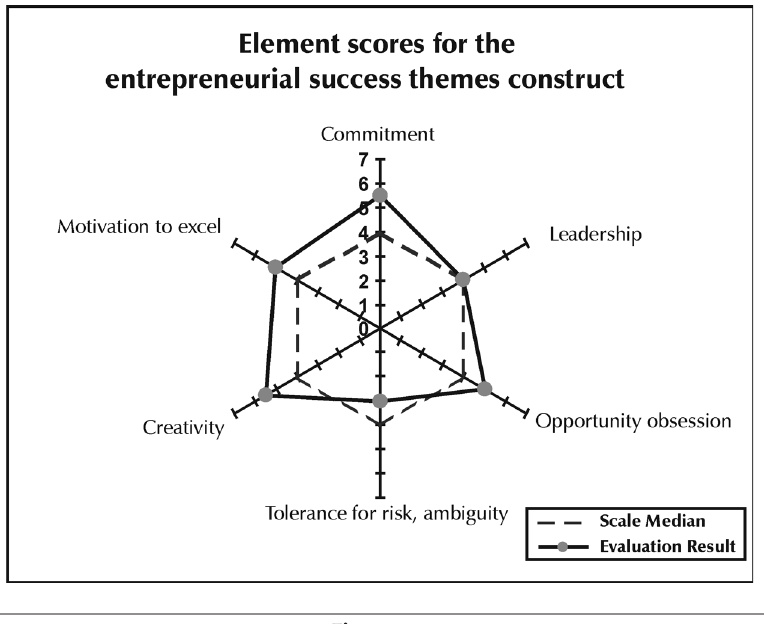
Graphical representation of evaluation results for the elements of the entrepreneurial success construct of the NVCL compared to the